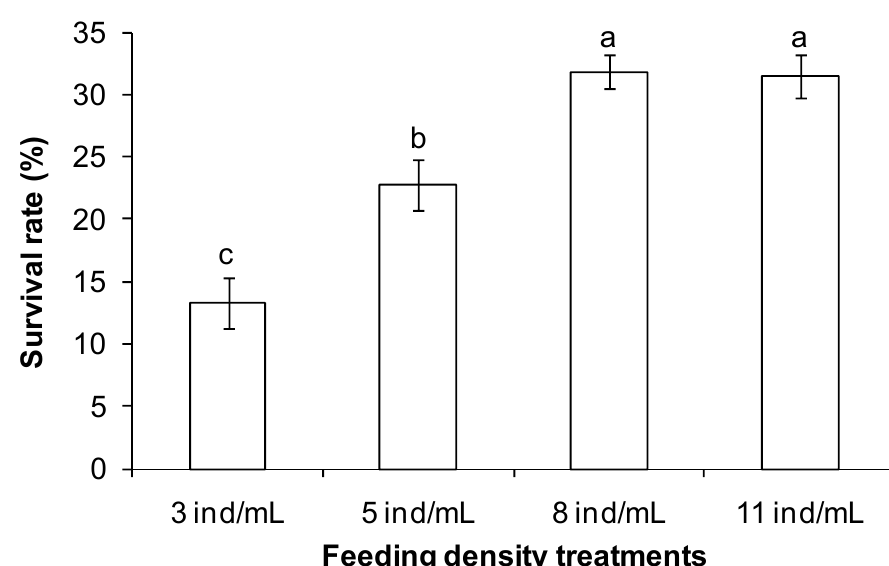
Figure 2. Survival rates of P. hypophthalmus larvae following 10 days of development under four feeding density treatments: 3 ind/mL, 5 ind/mL, 8 ind/mL, and 11 ind/mL. Each bar represents the mean and standard deviation data for each feed density treatment. Data with different letters are significantly different ( p < 0.05).